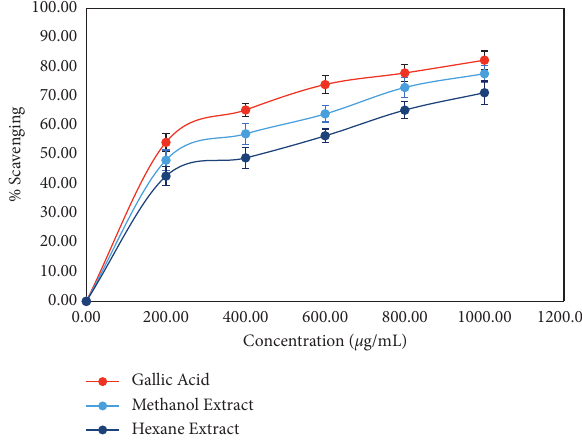
Figure 5: Hydrogen peroxide radical scavenging capacity of the extracts of V. camporum and gallic acid. Table 4: IC 50 of hydrogen peroxide radical scavenging activity of extracts of V. camporum .